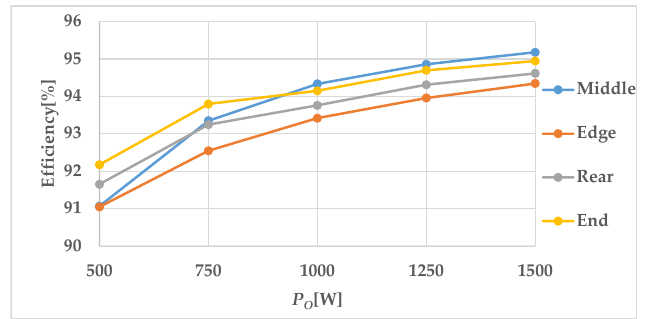
Figure 23. Efficiency comparison for the middle, edge, rear, and end sags.